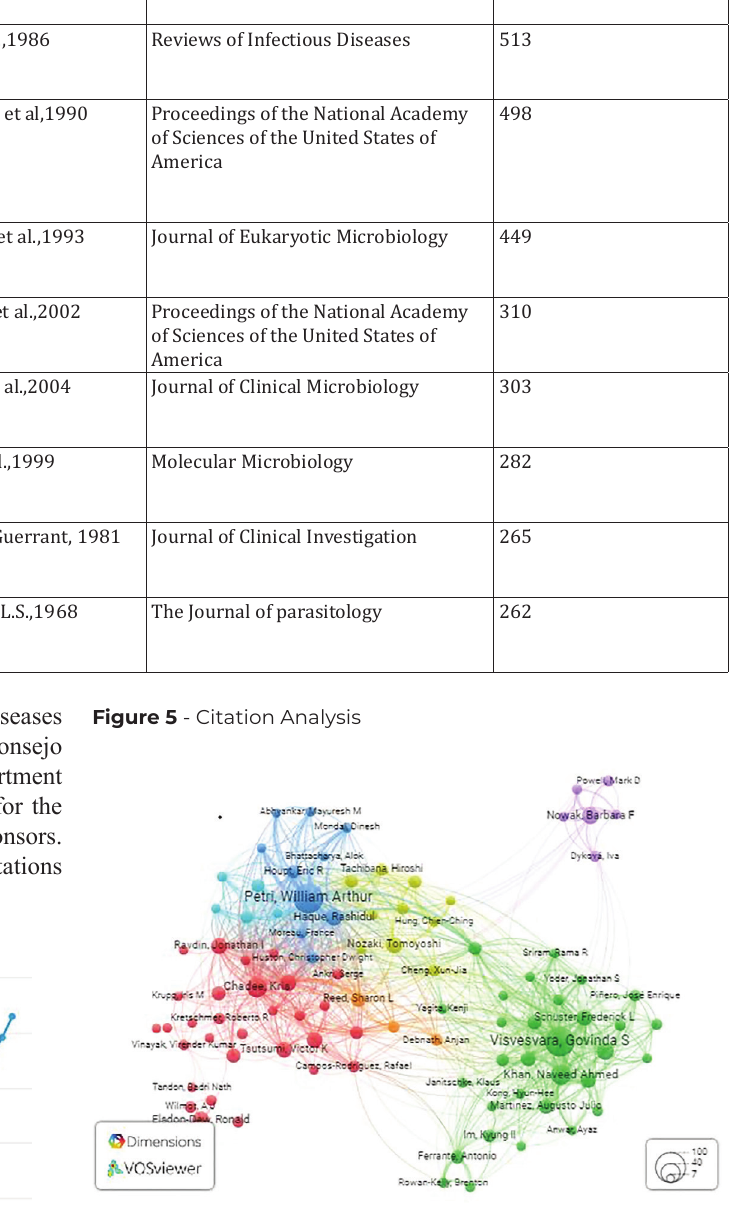
The examination of the top 10 documents in terms of citations (6-15).